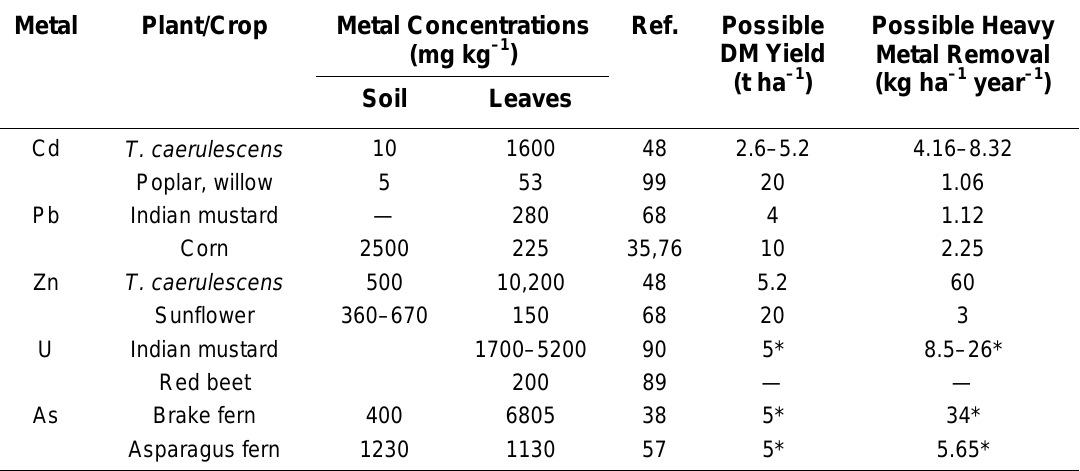
Phytoextraction Potential of Selected Species for Selected Metals Metal